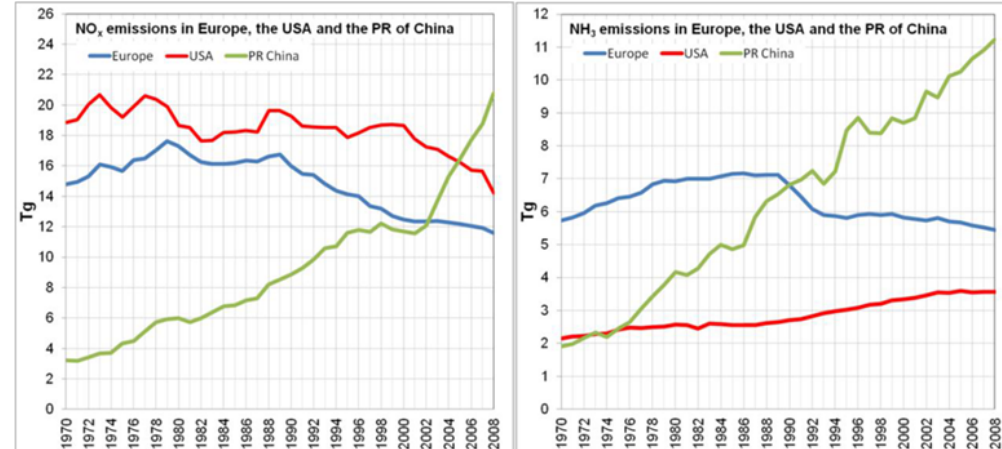
Fig. 5. Development of emissions of nitrogen oxides (left) and ammonia (right) in three world regions (Europe, USA, PR China) be- tween 1970 and 2008 based on the Emissions Database for Global Atmospheric Research (EDGAR) version 4.2 (Unit: Tg). For a more detailed analysis of N r emission trends, see Reis et al. (2009). Source: European Commission, Joint Research Centre (JRC)/Netherlands Environmental Assessment Agency (PBL). Emission Database for Global Atmospheric Research (EDGAR), release version 4.2. http: //edgar.jrc.ec.europa.eu,